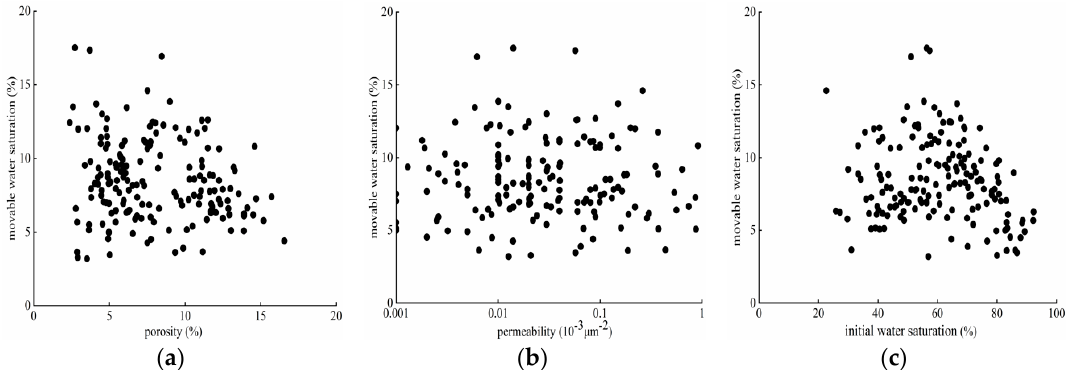
Figure 9. Movable water saturation versus porosity ( a ), permeability ( b ) and initial water saturation ( c ).